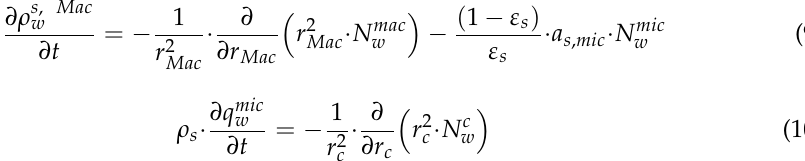
ing in q Mac w ered to be in the adsorbed phase, and so, ρ s , mic w = 0. Equations (3) and (6) turn into Equations (9) and (10).